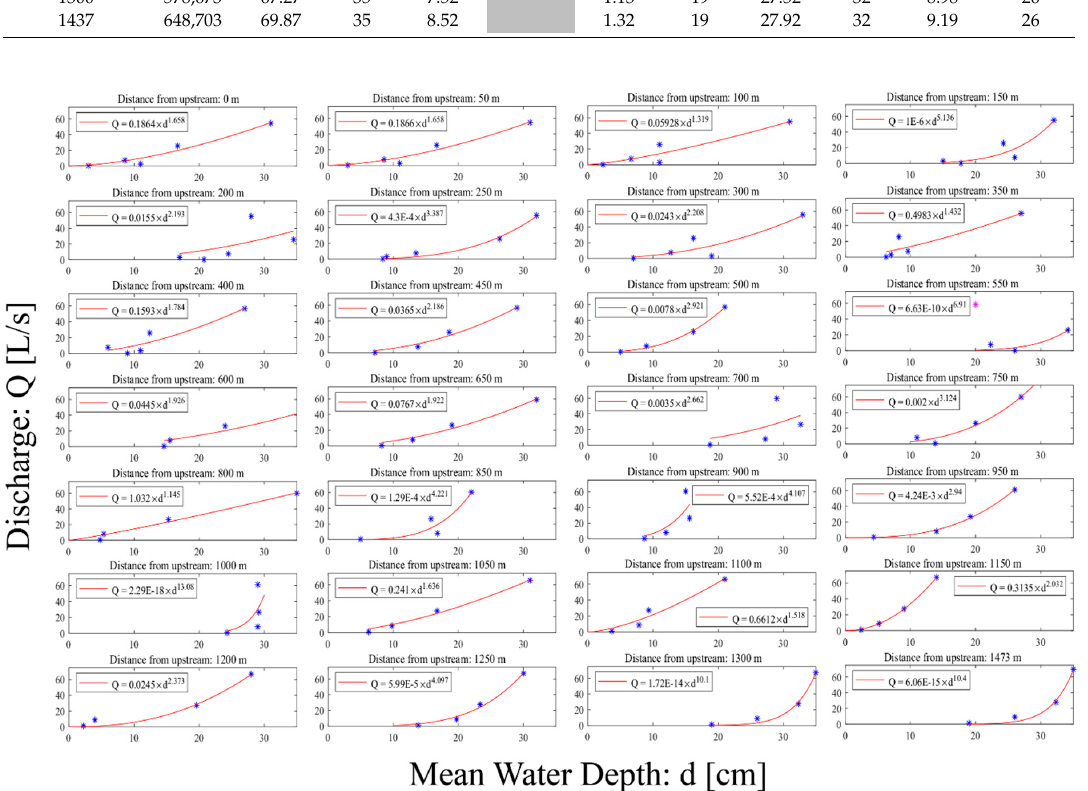
Figure 2. Relationships between discharge and water depth at a spatial resolution of 50 m (one of the discharge values at a distance of 550 m from the upstream station (shown with a magenta star) was not considered in the analysis due to its unrealistic value, which might be due to measurement